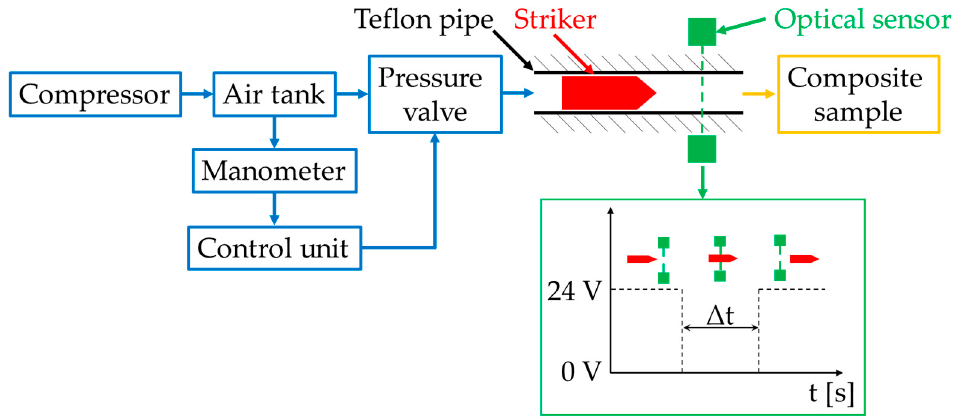
Figure 4. Scheme of the test stand with the pneumatic launcher used in the experiment.